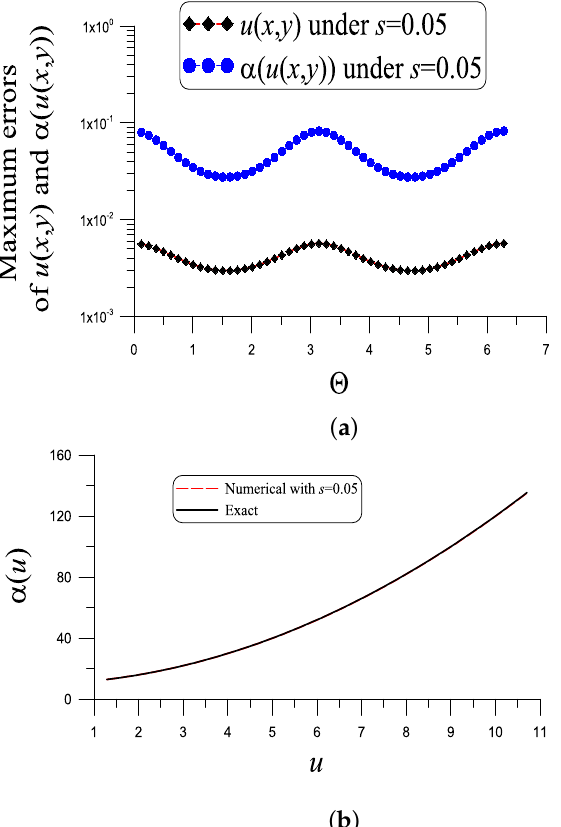
Figure 4. For example 3, showing ( a ) the errors in the numerical recovery of u and α and ( b ) the numerical recovery of α under a noise s =